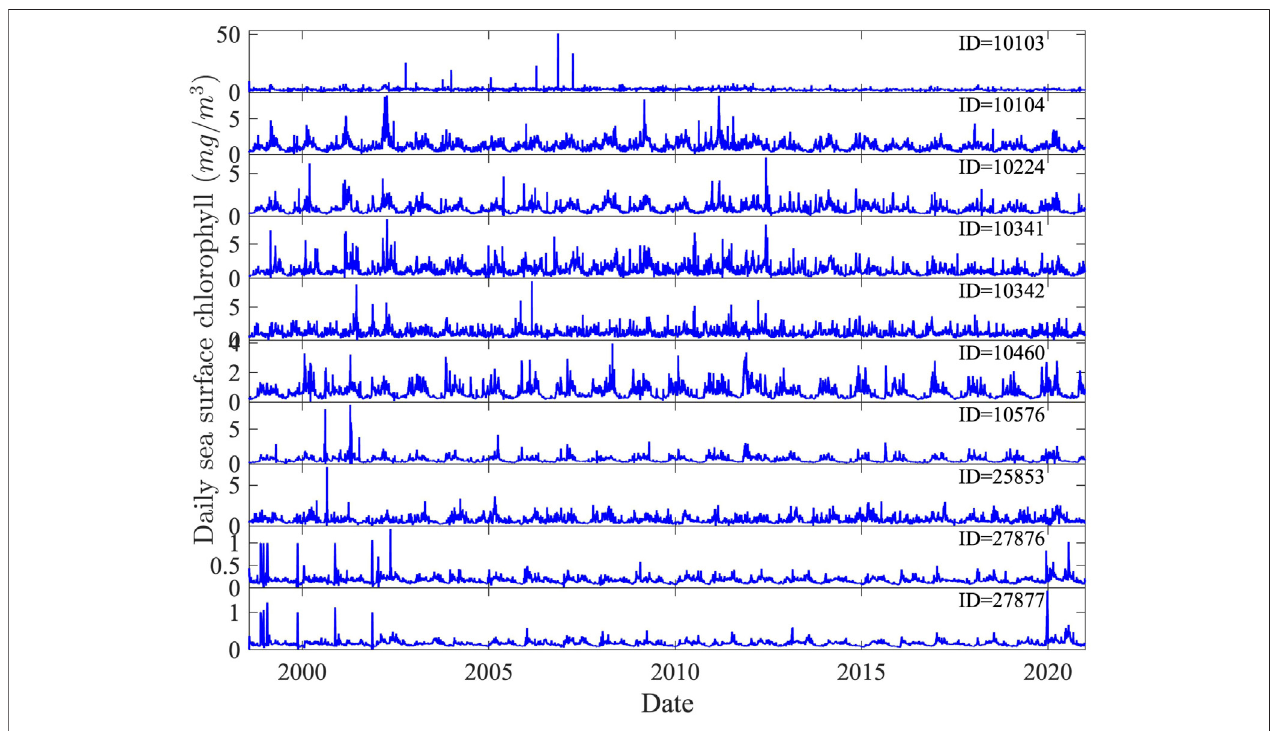
FIGURE 3 | Sea surface chlorophyll time series at the 10 chosen locations.